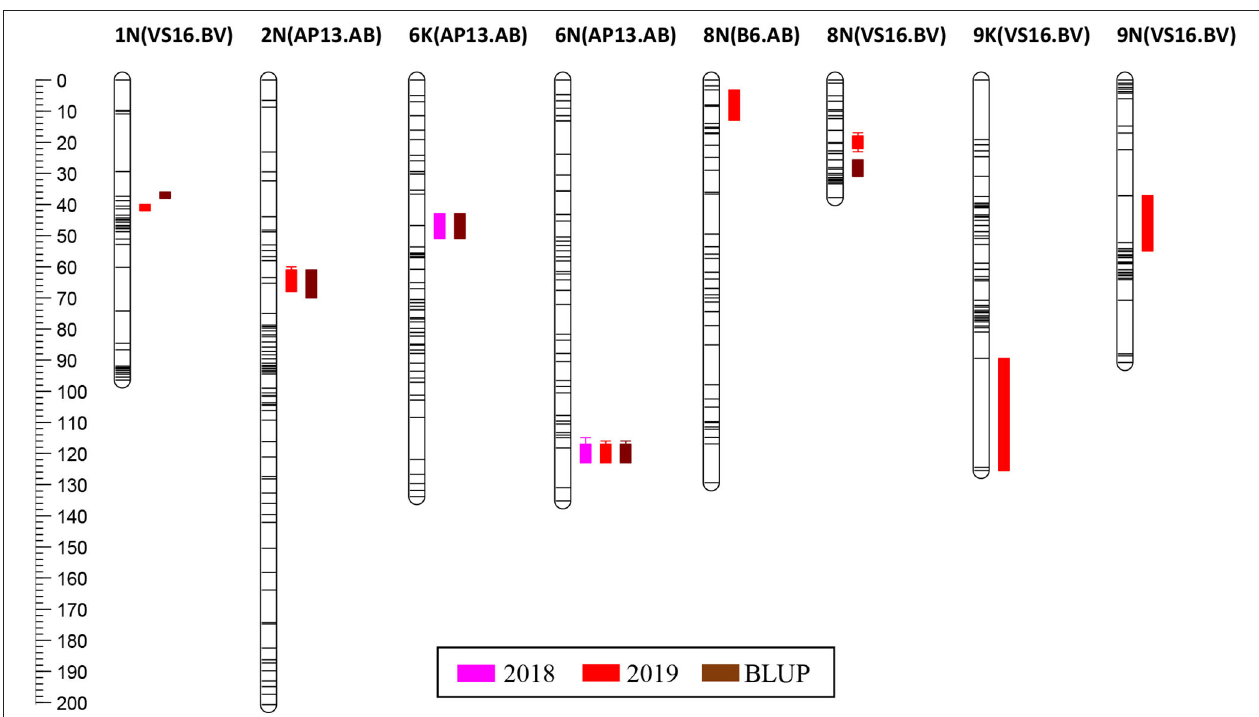
FIGURE 4 | QTL positions on the genetic map. QTL are positioned at the right side of each LG; solid bars and whiskers on one or both ends represent coverage at LOD drop intervals of 1.0 and 2.0, respectively. QTL were mapped using LS means for each year and the BLUP value.